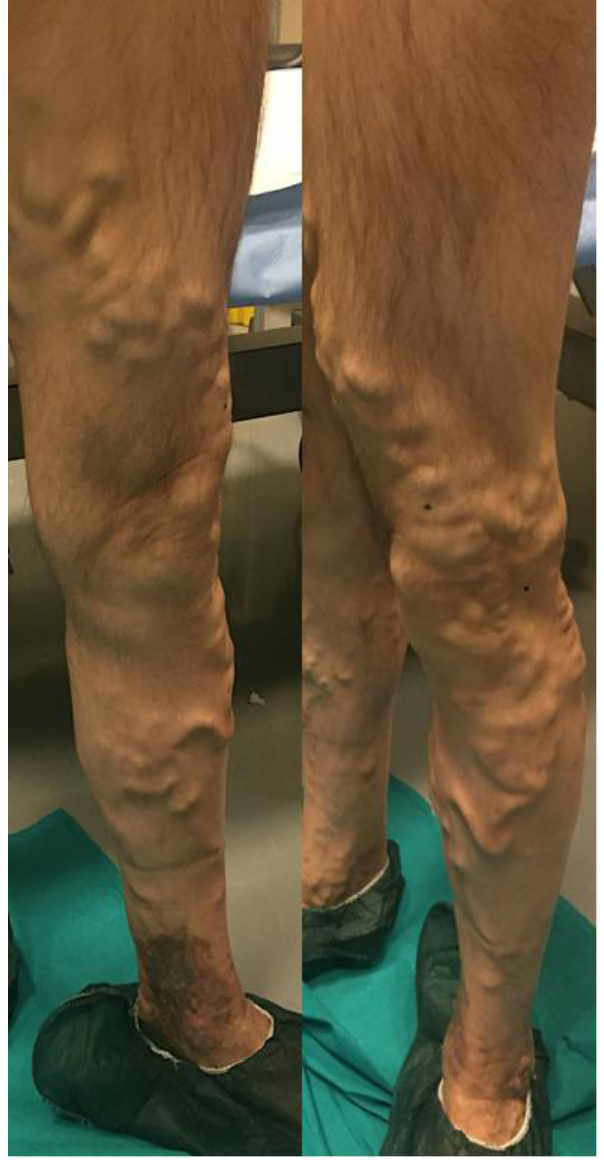
Figure 1. Preoperative photo of varicose veins of the great saphenous vein and collateral veins of the lower left limb.